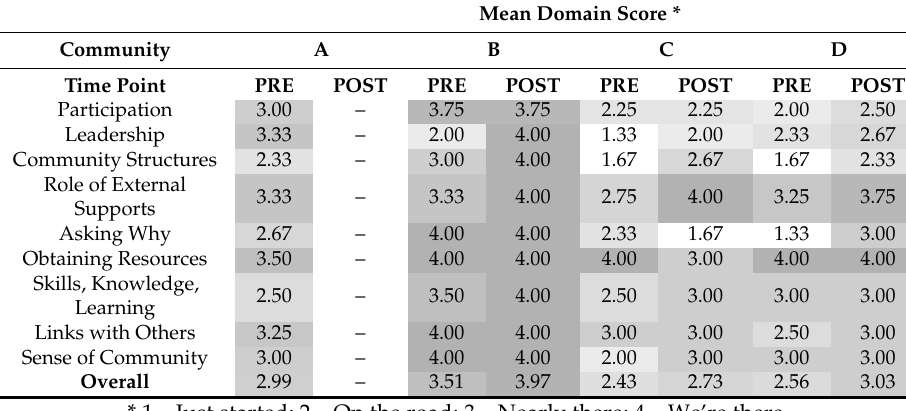
Table 3. CCBT scores for Communities A–D.